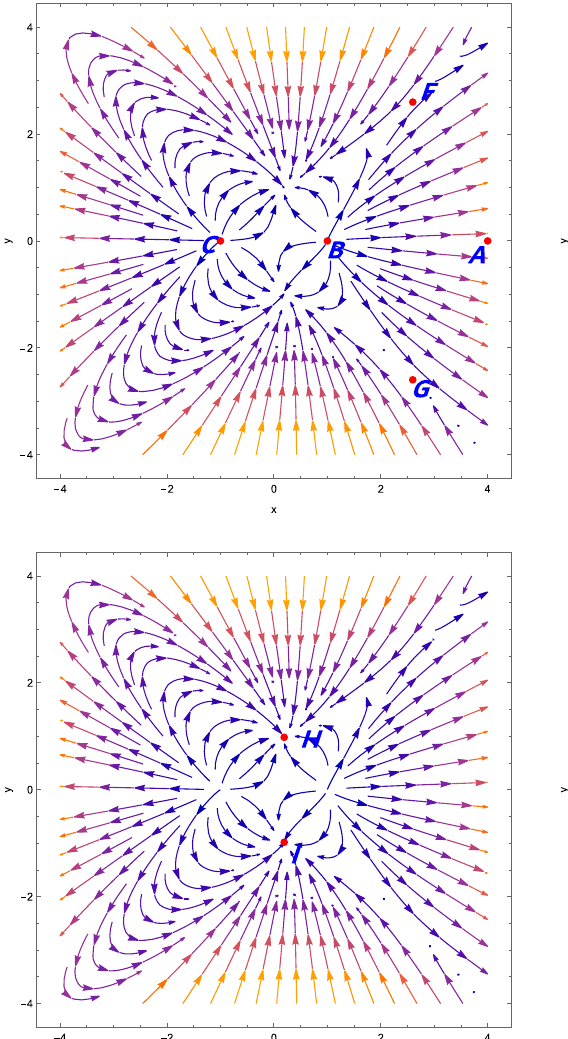
ρ = 0 and ζ = 1 . The lower left phase portrait is for u = 0, ρ = 0 and (cid:13) 9 λ = 2 and lower right phase portrait is for u = 0 and ρ = 9